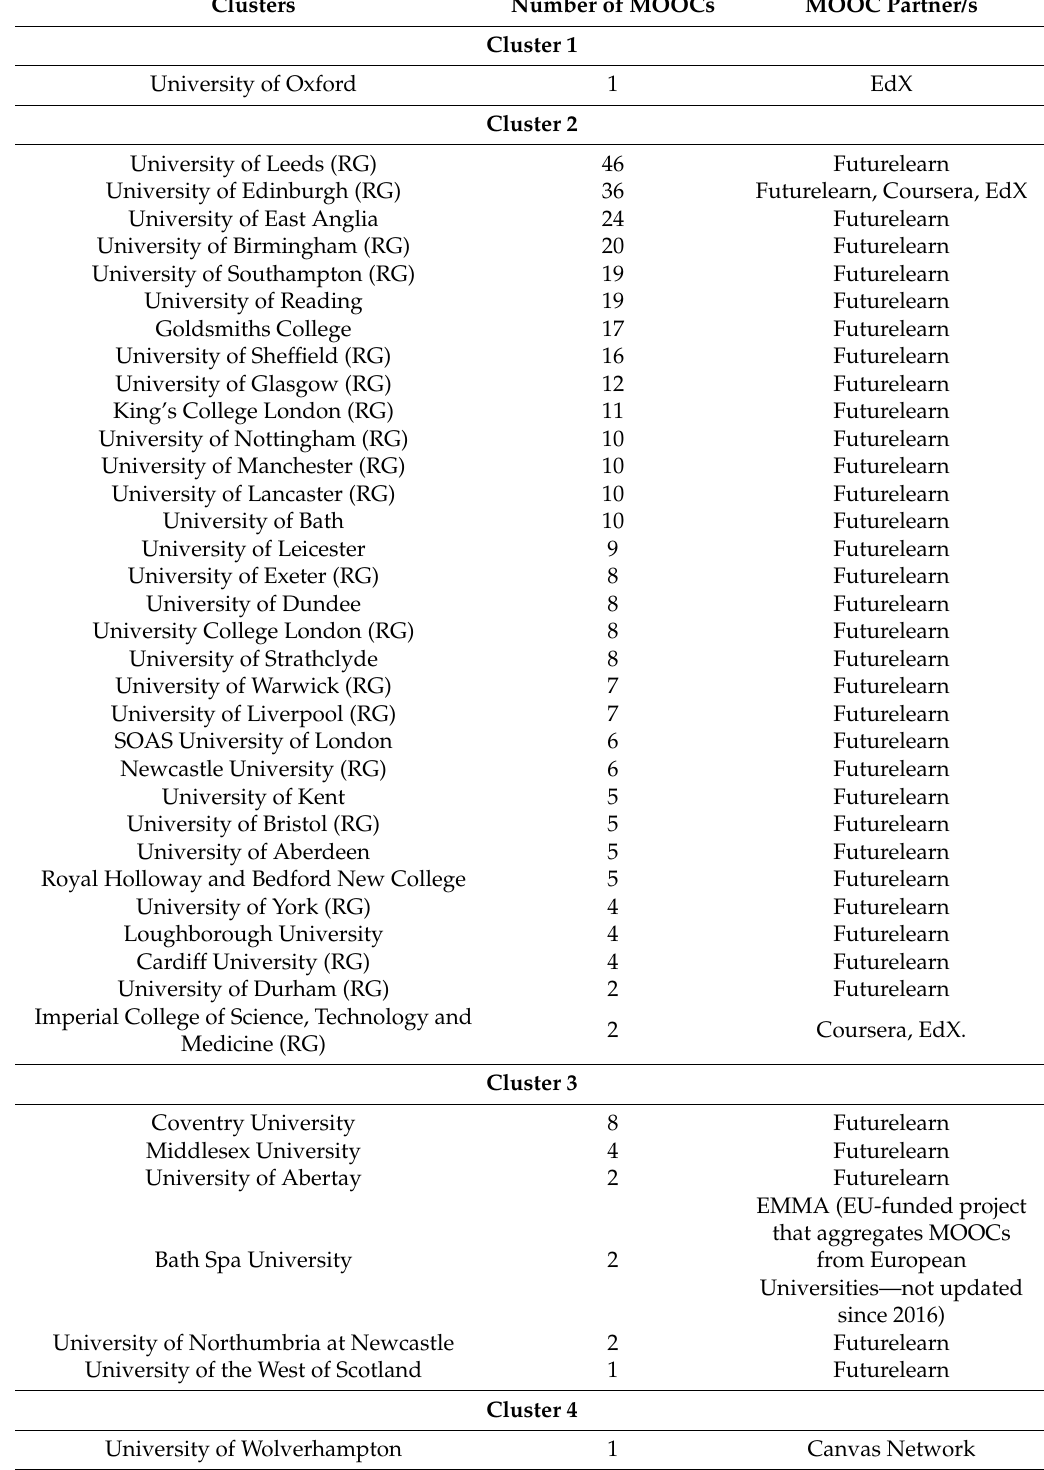
Table 1. Massively Open Online Course (MOOC) provision in the stratified context of UK higher